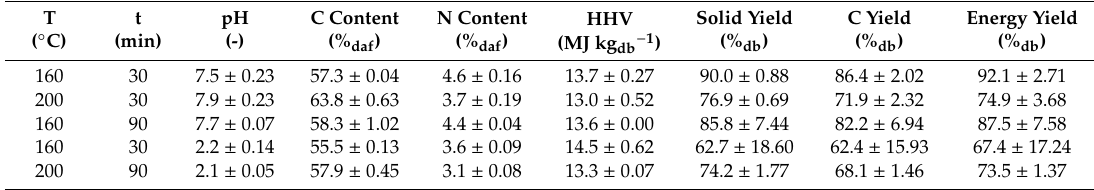
Table 4. Hydrochar (HC) properties in relation to reaction